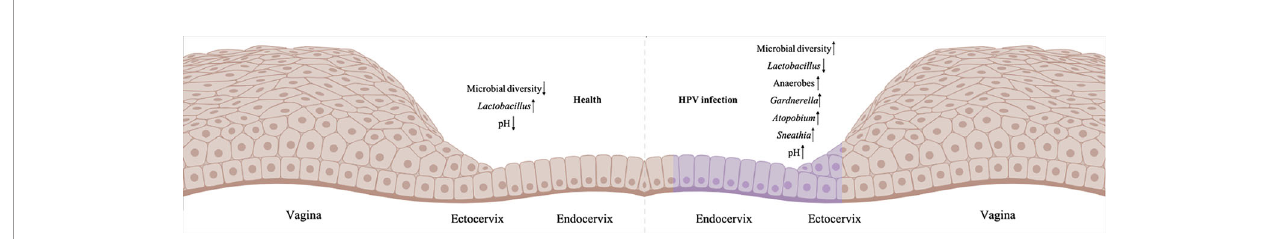
FIGURE 1 | Imbalanced CVM in HPV-infected cervix. The left is the normal cervicovaginal microenvironment without HPV infection, and the right is HPV-positive microenvironment (HPV-infected cells are labelled purple). Created in